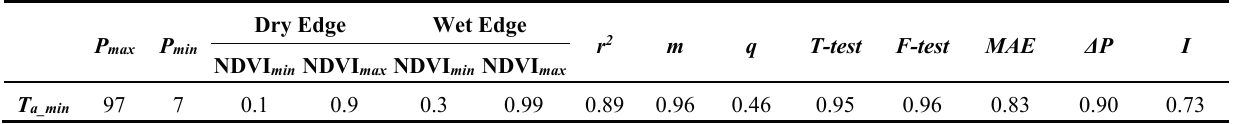
Table 3. T a_min parameters fine-tuning.